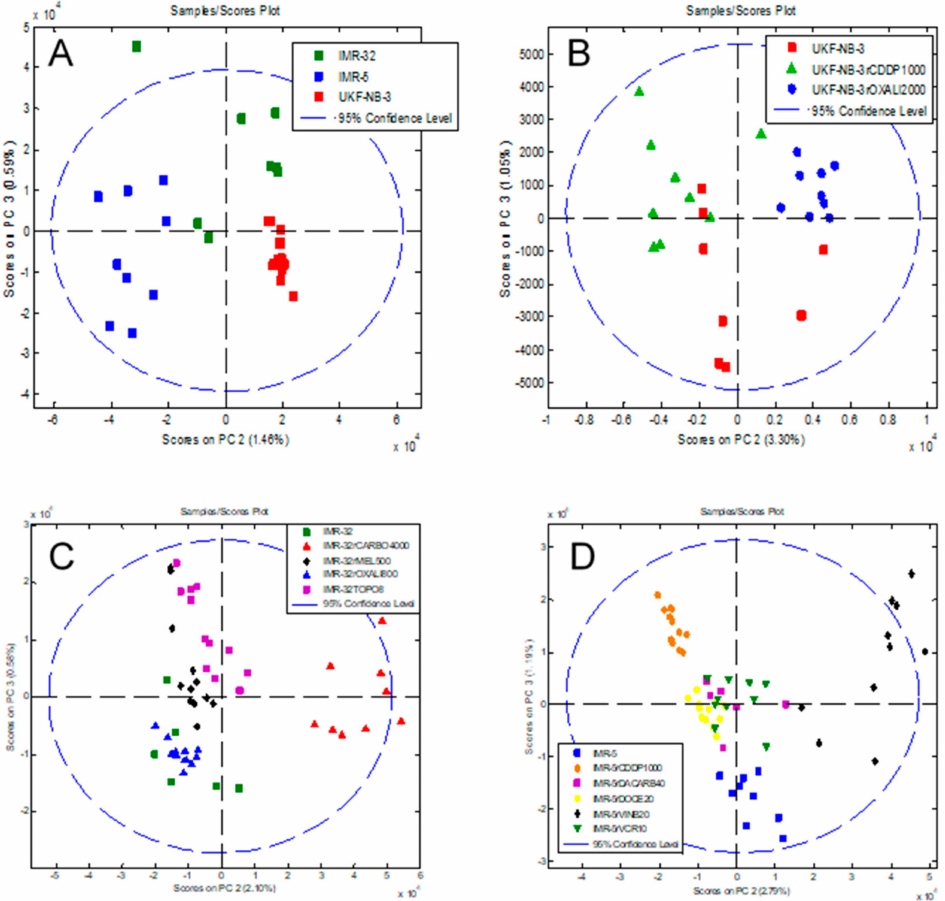
Figure 5. Principal component analysis (PCA) of the intact-cell MALDI-ToF mass spectrometry spectra data derived from the di ff erent cell lines, showing a plot of component PC2 vs. PC3 that allows discrimination of di ff erent cell subtypes and resulted in the best discrimination of the cell lines. (A) Parental cell lines IMR-32, IMR-5 and UKF-NB-3. The comparisons PC1 vs. PC2 and PC1 vs. PC3 are presented in Figure S4. (B) UKF-NB-3 and its drug-adapted sublines. The comparisons PC1 vs. PC2 and PC1 vs. PC3 are presented in Figure S5. (C) IMR-32 and its drug-adapted sublines. The comparisons PC1 vs. PC2 and PC1 vs. PC3 are presented in Figure S6. (D) IMR-5 and its drug-adapted sublines. The comparisons PC1 vs. PC2 and PC1 vs. PC3 are presented in Figure S7. In each case, the individual data points represent the analysis of a single biological cell line. For each of the host or drug-adapted cell lines, three biological cultures were analysed in triplicate by intact-cell MALDI-ToF and thus there are nine data points for each cell